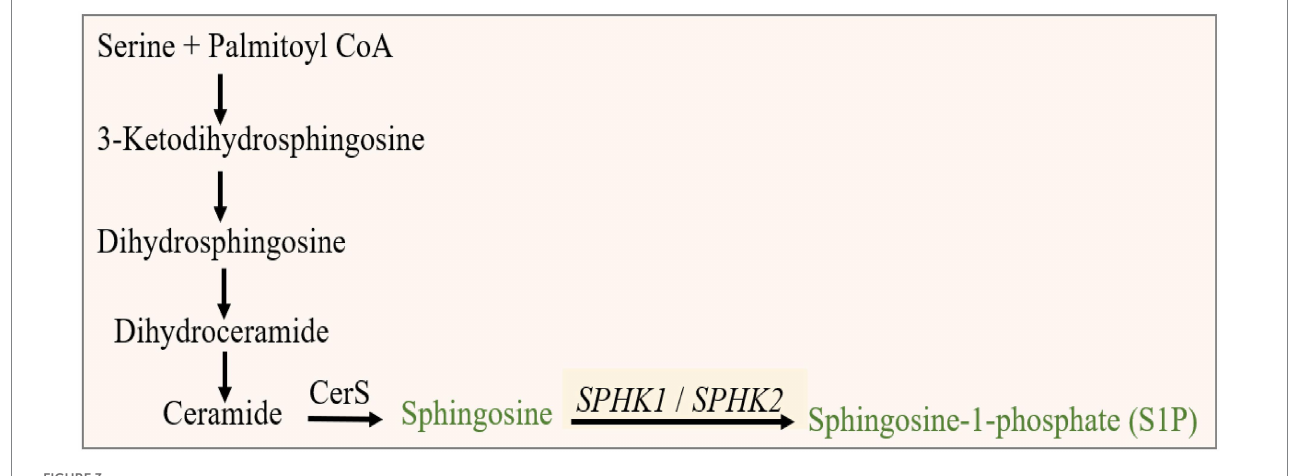
FIGURE 3 Sphingolipid metabolism pathway illustrates the processes of sphingosine-1-phosphate (S1P) production. The last step is catalyzed by SPHK1 , a significant protein-coding gene associated with autism in Saudi females.